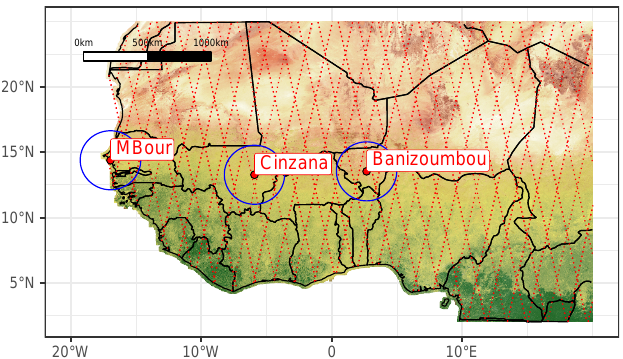
Figure 1. AERONET and PM10 monitoring stations in the Sahel and (blue circle) 250 km range around the stations. (dotted lines) CALIPSO/CALIOP ground tracks. Coloring of the background map based on land cover (see